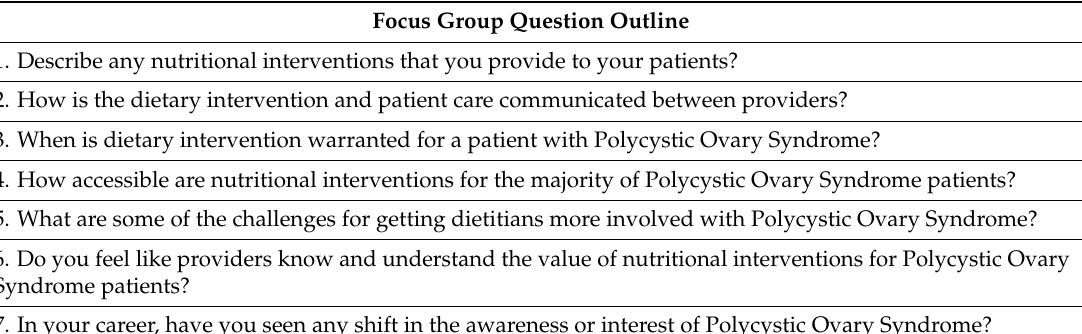
Table 1. Outline of questions for focus group used in a qualitative study on involving